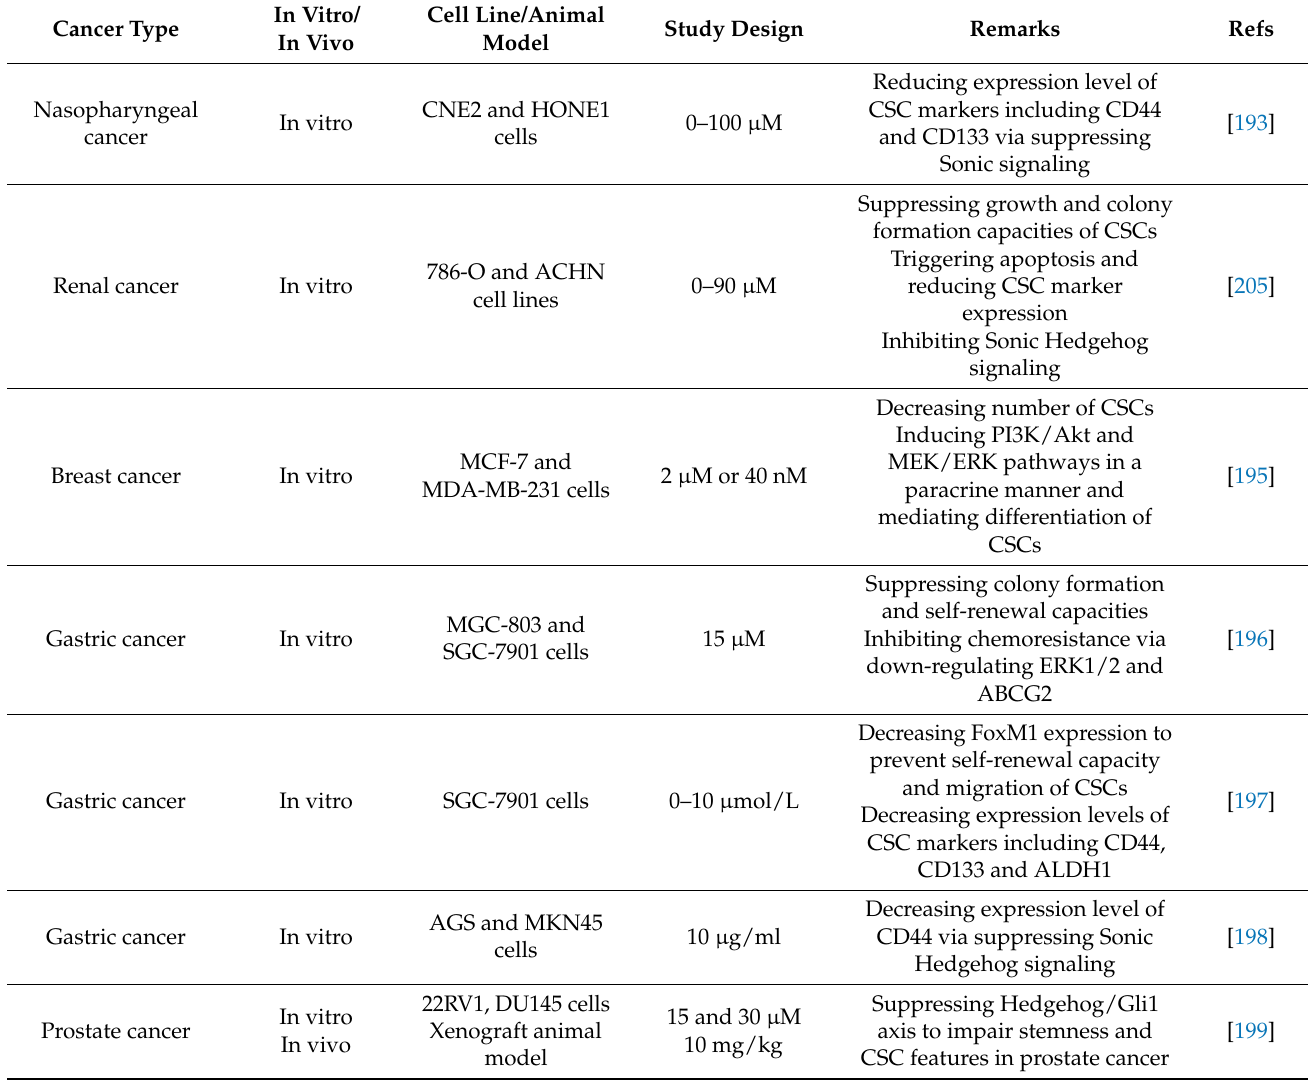
Table 3. The potential of genistein in cancer suppression via targeting